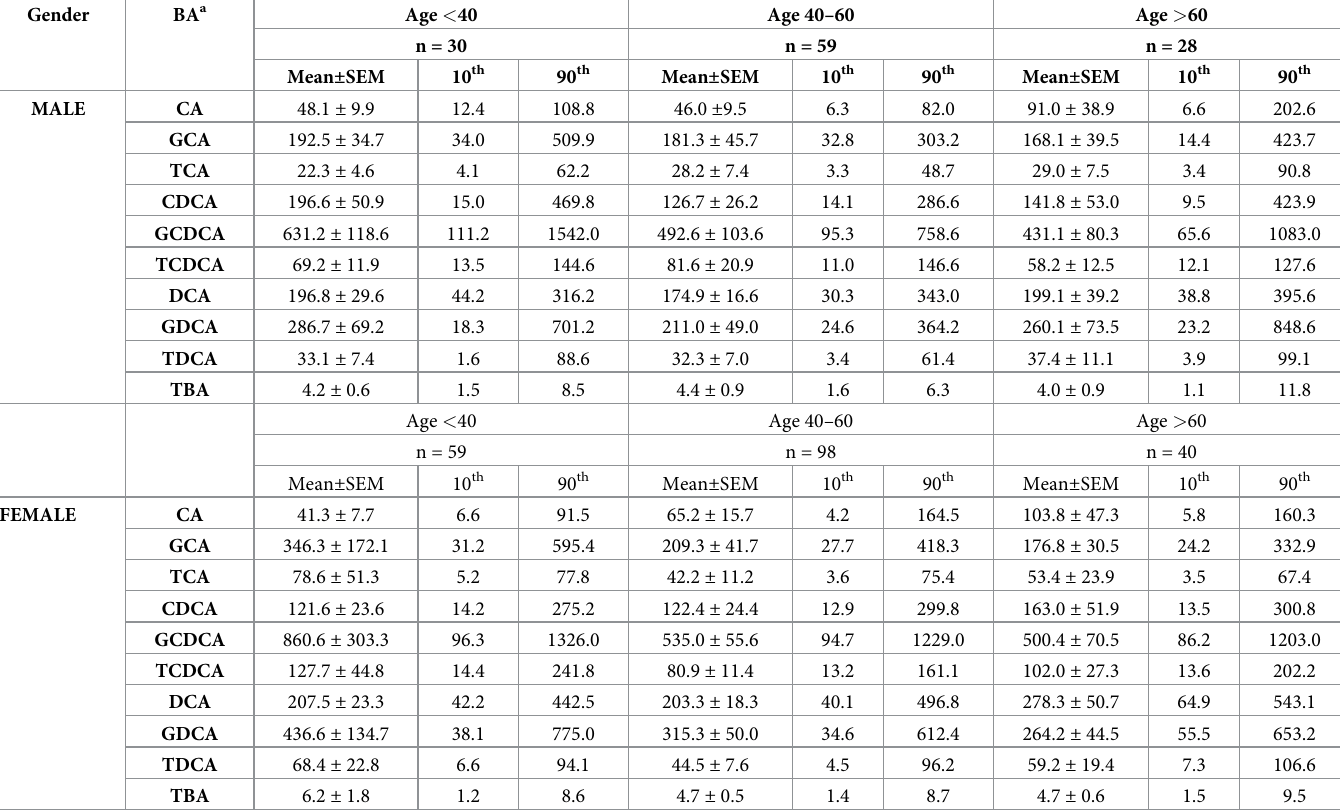
Table 1. Mean serum bile acid concentrations in healthy subjects by age and gender. Gender BA a